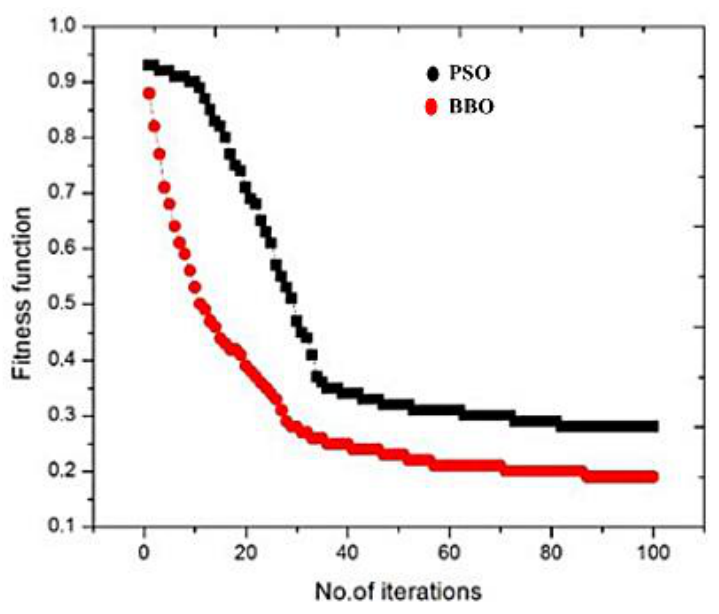
Figure 7. Convergence plot for BBO and PSO algorithm.